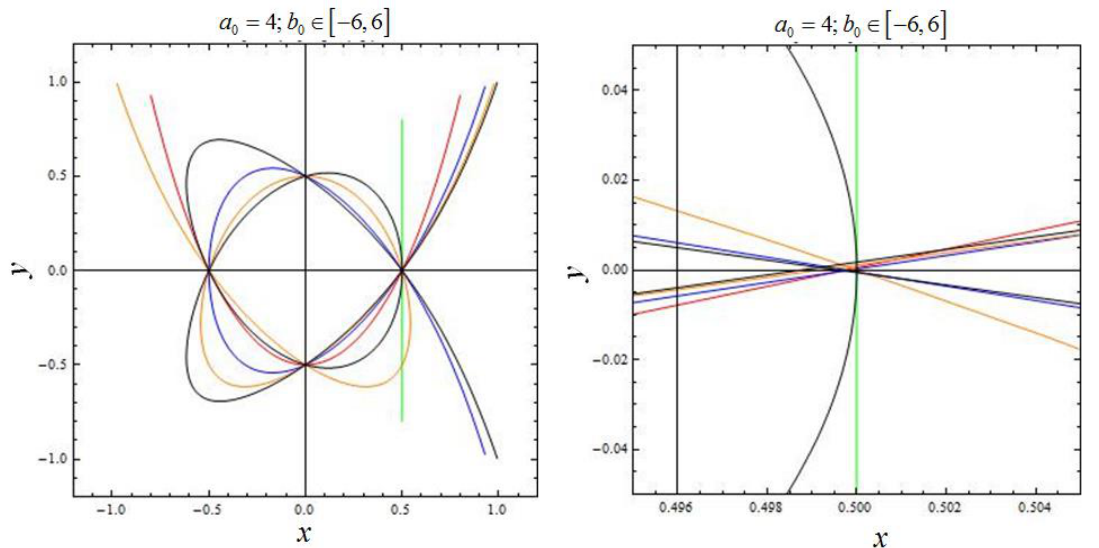
Figure 2. Plotting of the curves